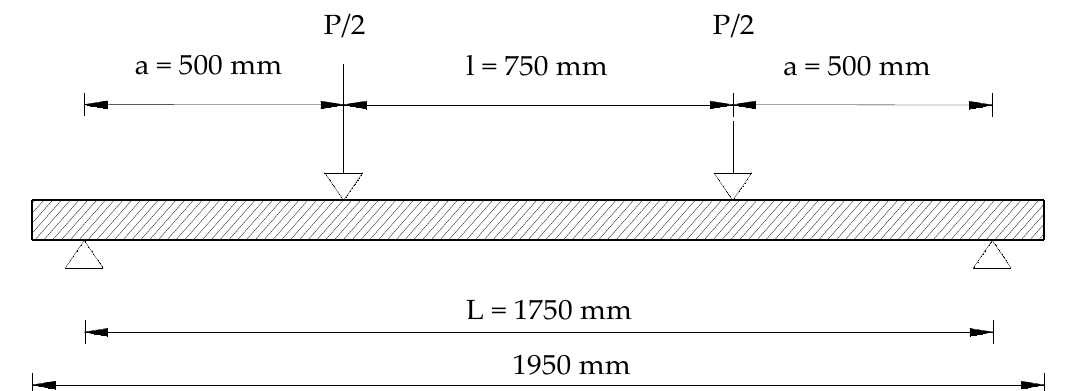
Figure 3. Schematic diagram of the four-point bending test field configuration for the specimens of Series S1.